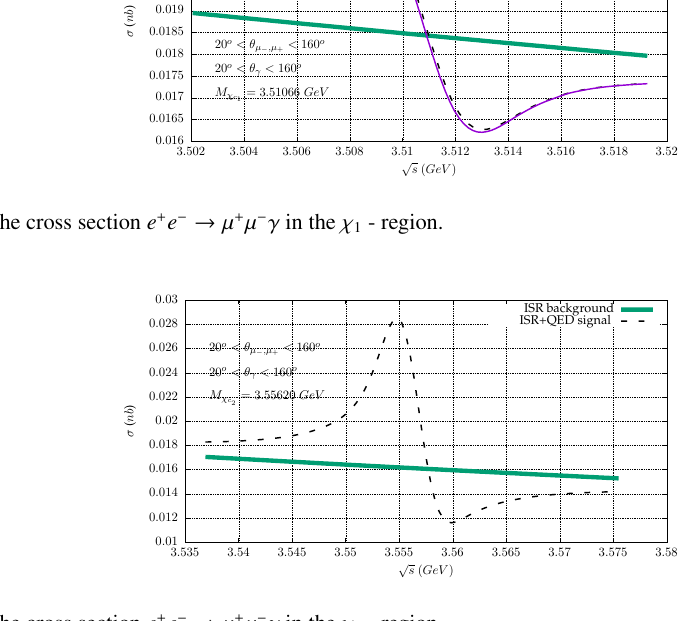
Figure 4. The cross section e + e −